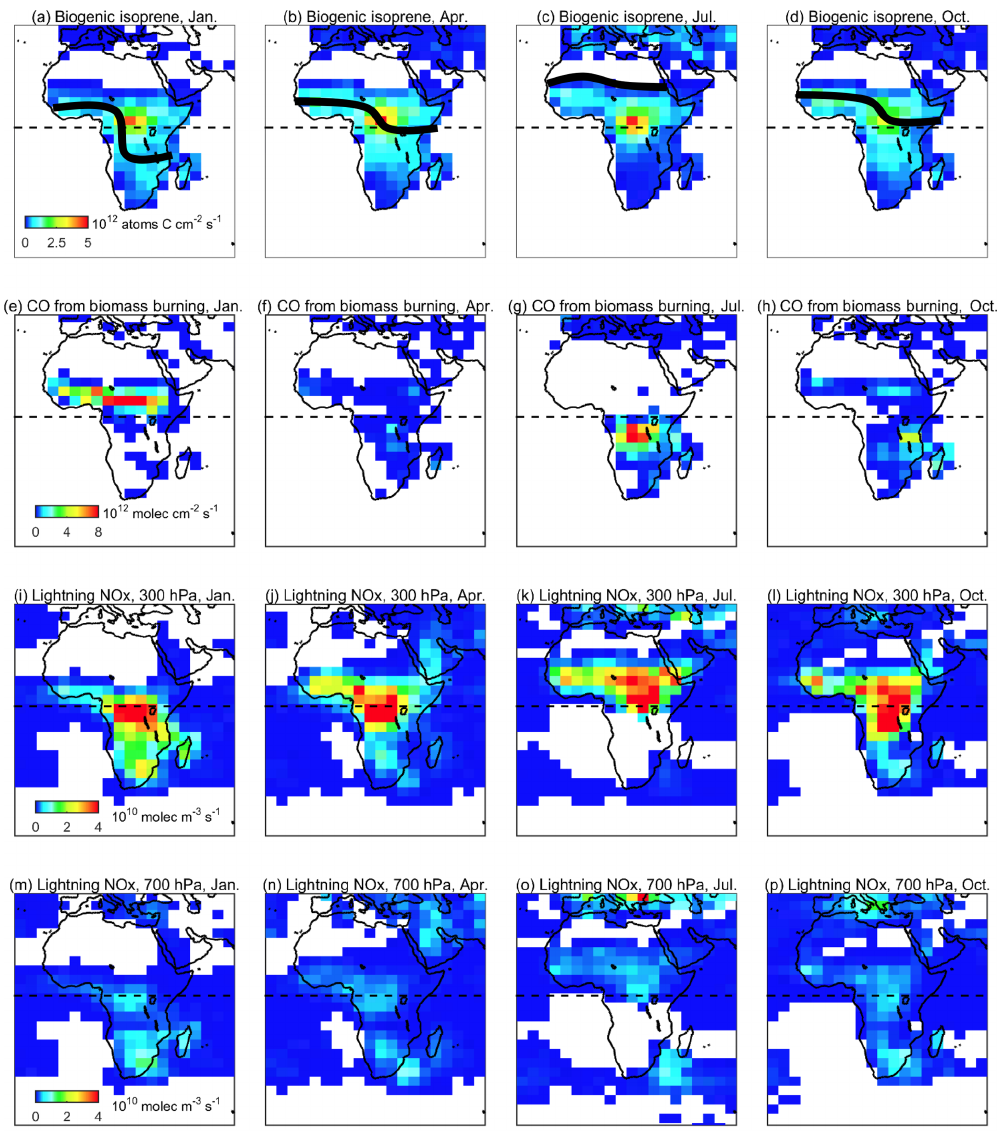
Figure 8. Distributions of isoprene emissions from biogenic sources (a–d) , CO emissions from biomass burning (e–h) , and NO x emissions from lightning at 300hPa (i–l) and 700hPa (m–p) by season in 2005. The data are based on the emission inventories in GEOS-Chem (see Sect. 2.1). The dashed lines indicate the equator. The black solid lines indicate the seasonal variation in the location of the ITCZ.